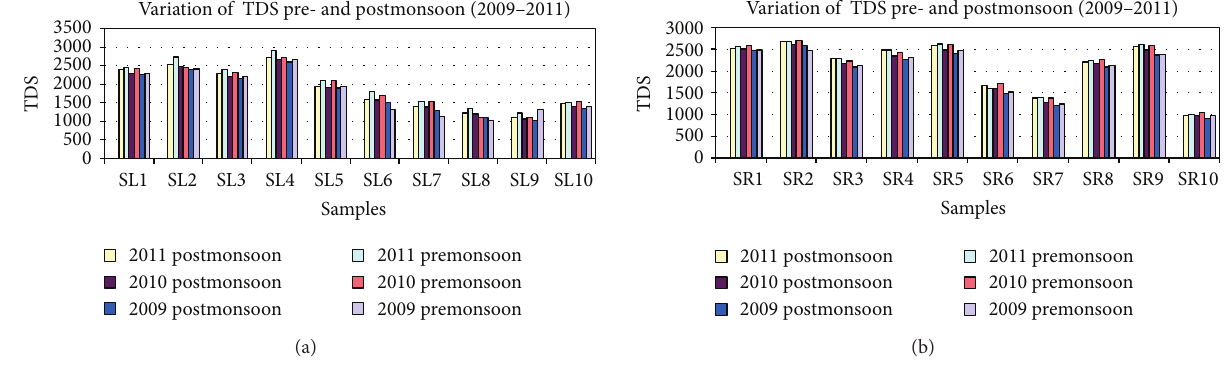
Figure 4: (a) Observations of TDS in water from the sites SL1–SL10 for the pre- and postmonsoons of 2009–2011. (b) Observations of TDS in water from the sites SR1–SR10 for the pre- and postmonsoon of 2009–2011.